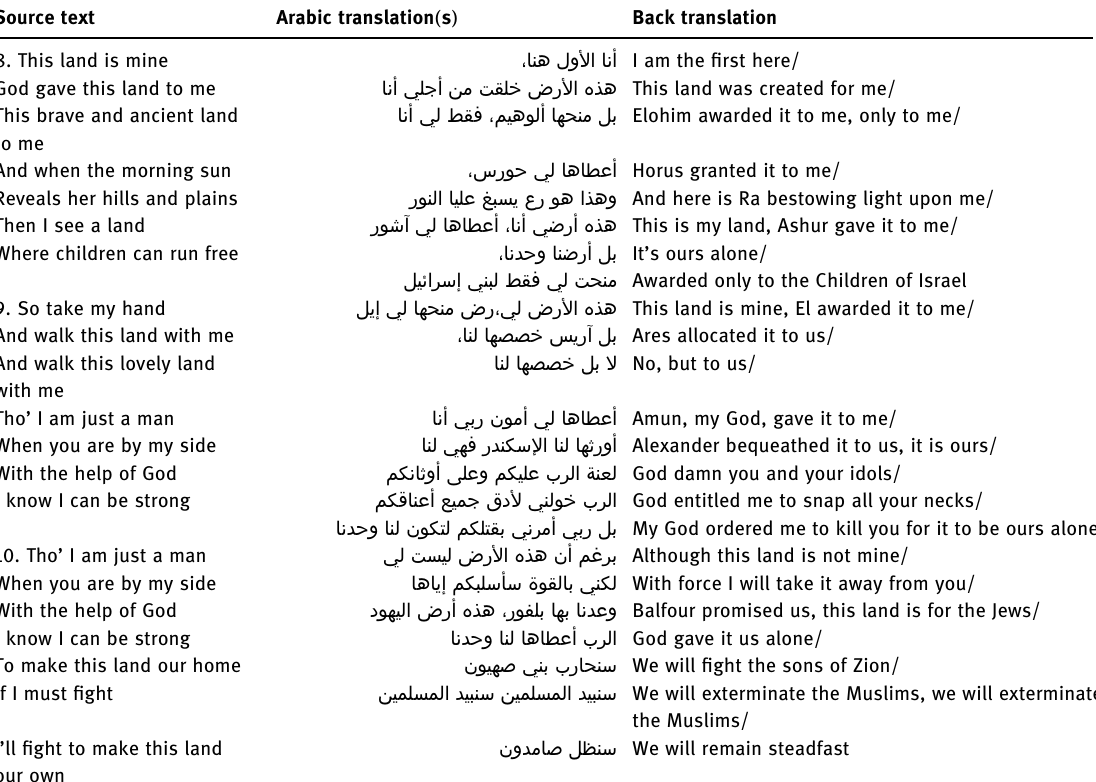
Table 3: Examples of visual explicitation Source